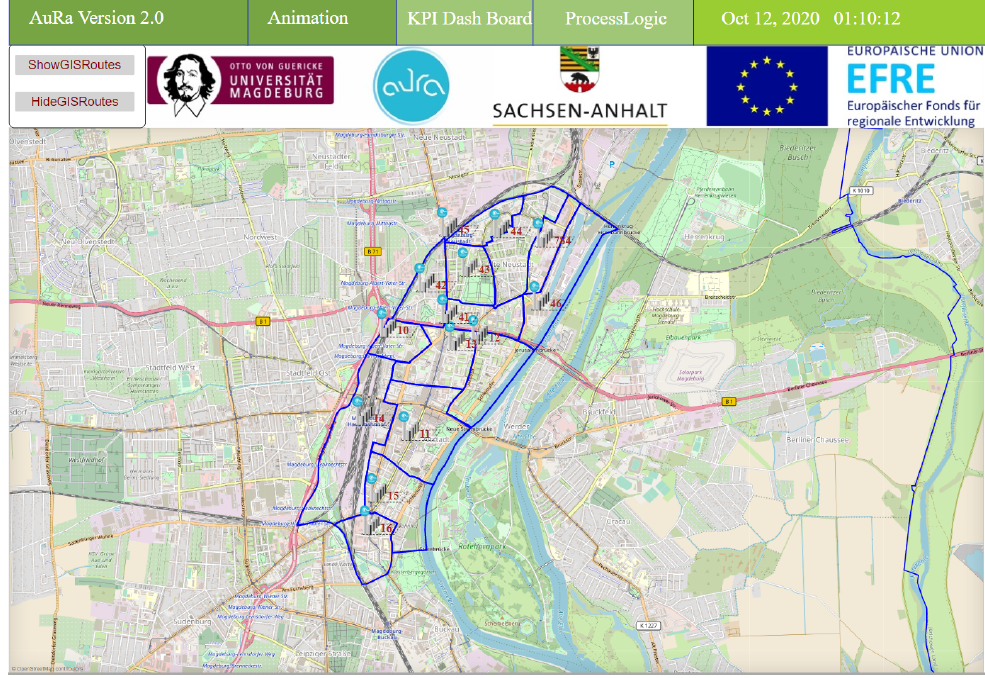
Figure 4. Operational area inner-city